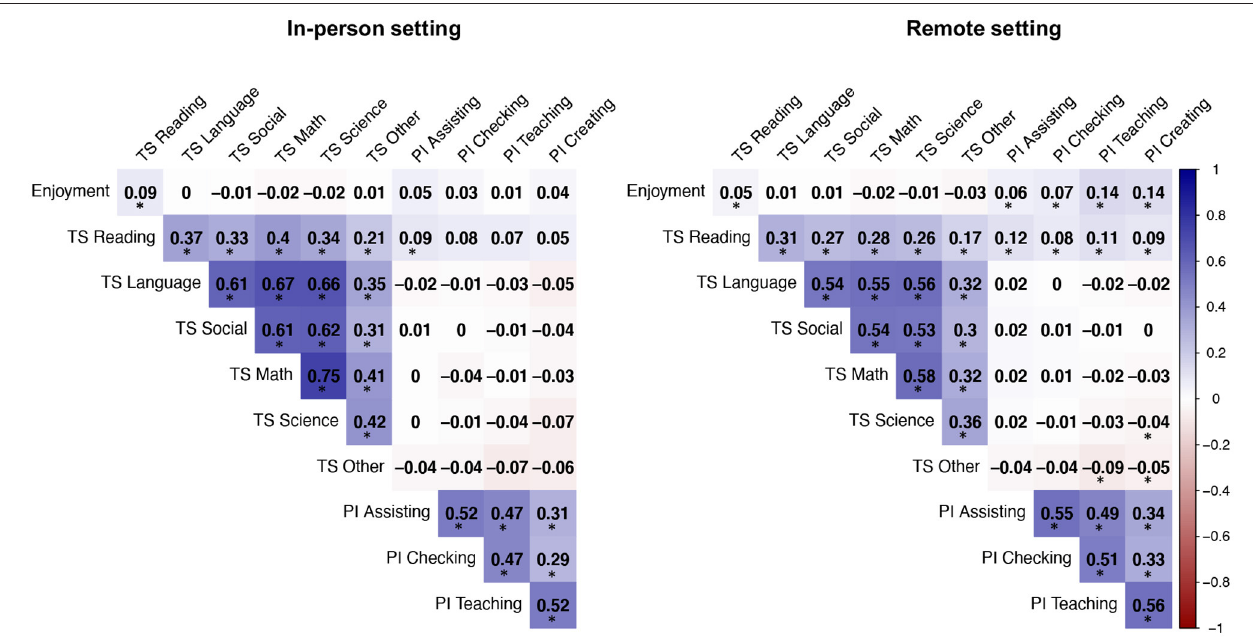
FIGURE 4 | Pearson correlation coefficients between our variables of interests within in-person schooled (left part) and remotely schooled youth (right part). Asterisks indicate significant coefficients at p < 0.05 (with Holm-Bonferroni correction). TS, Time Spent; PI, Parental